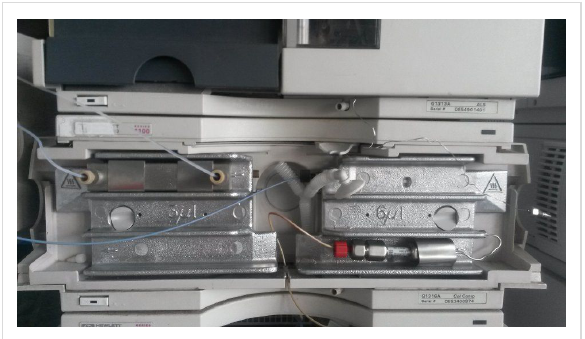
Figure 7: RD2 held in place within the thermostatted Agilent 1100 series column department.